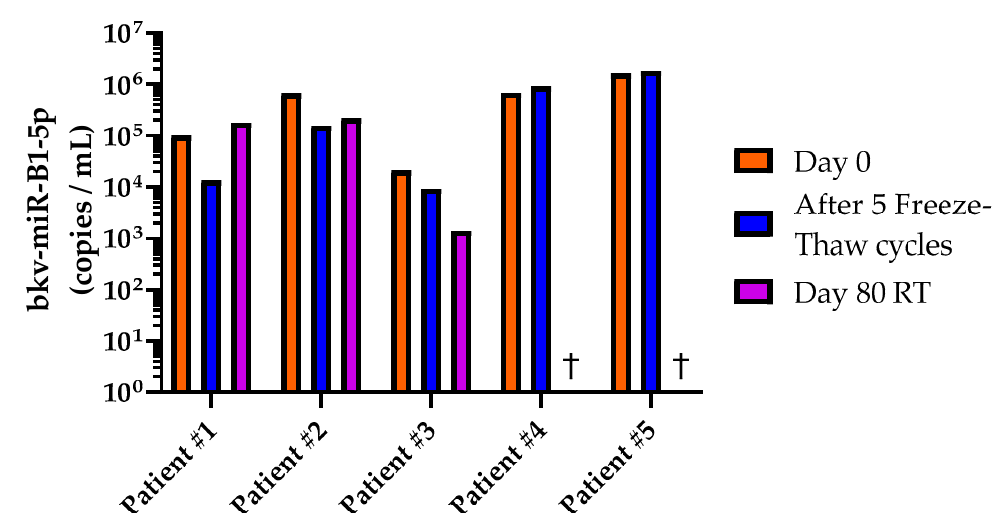
Figure 2. bkv-miR-B1-5p levels in urine from patients diagnosed with a BKPyV infection. The measurements were performed at day 0 (orange bars), after five freeze-thaw cycles following 80 days of − 20 ◦ C conservation (blue bars), or after 80 days of room temperature (RT) conservation (purple bars). †: zero value. The five experiments were independently performed between March 2021 and December 2021.